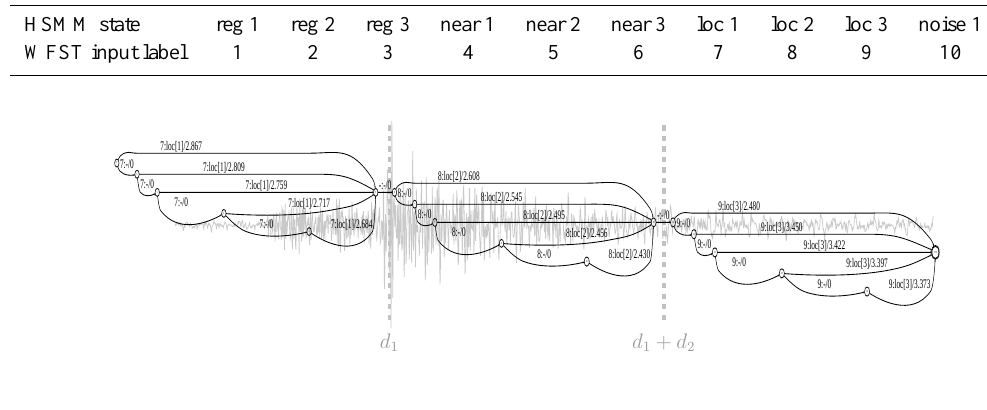
probability of this transition of 8 . 032 which corresponds